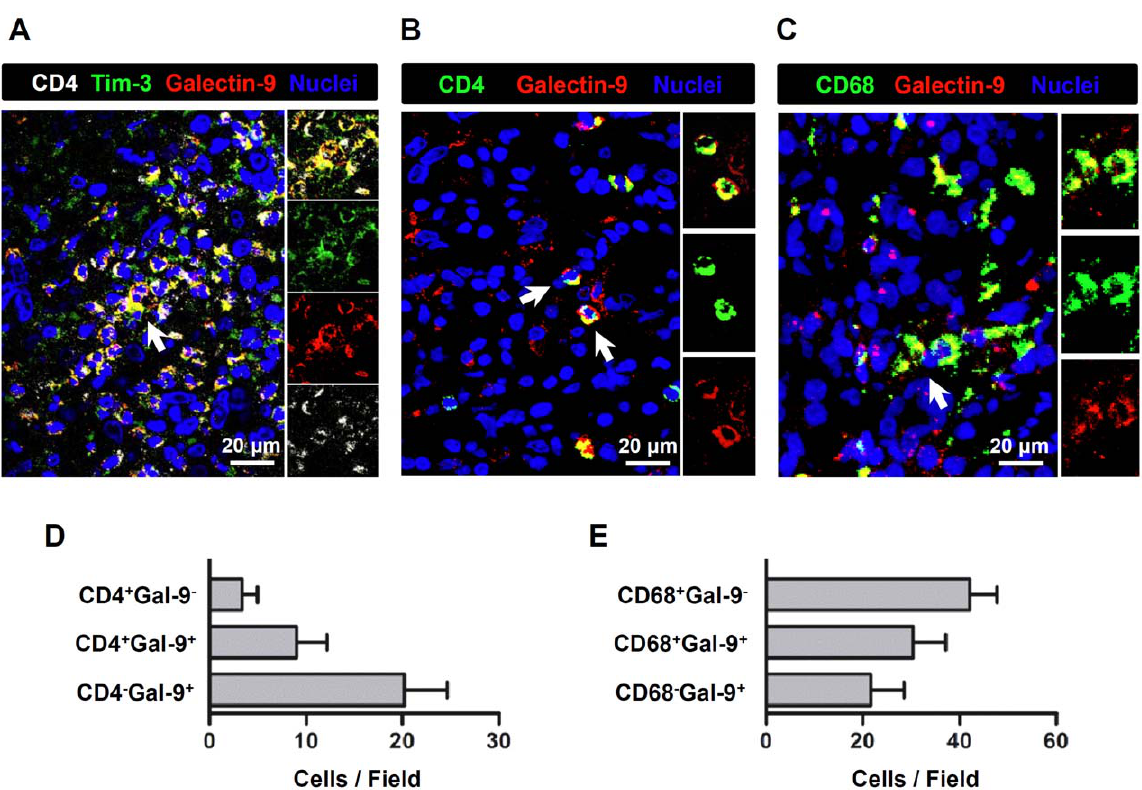
Figure 5. Close interaction between Tim-3 + CD4 + cells and galectin-9 + cells in HCC tumor tissue. A . Paraffin-embedded HCC tumor sections were subjected to multi-color immunofluorescence staining for CD4 (white), Tim-3 (green), galectin-9 (red) and nuclei (DAPI, blue). Confocal analysis showed that Tim-3 + CD4 + cells were in close contact with galectin-9 + cells in the tumor nest. B . Paraffin-embedded HCC tumor sections were subjected to multi-color immunofluorescence staining for CD4 (green), galectin-9 (red) and nuclei (DAPI, blue). Confocal analysis indicated that galectin-9 was expressed by the tumor-infiltrating CD4 + cells. C . Paraffin-embedded HCC tumor sections were subjected to multi-color immunofluorescence staining for CD68 (green), galectin-9 (red) and nuclei (DAPI, blue). Confocal analysis indicated that galectin-9 was expressed by tumor-infiltrating CD68 + macrophages. White arrows in A–C indicate the magnified cells. Images are representative of 13 samples. For the quantification of CD4 + / 2 galectin-9 + / 2 cells (D) or CD68 + / 2 galectin-9 + / 2 (E) cells, eight CD4 or CD68 hot-spot fields per slide were taken with 40 6 oil- immersed objective lens. Numbers of each subset cells were counted manually by two independent, blinded observers. Gal-9 in D and E is short for galectin-9.